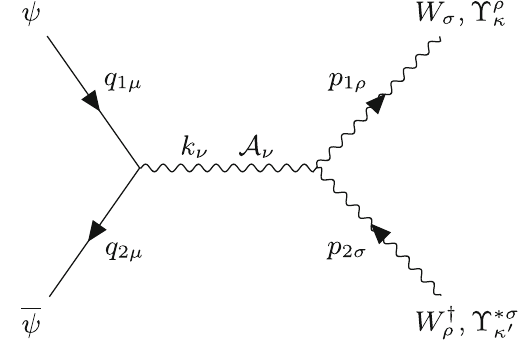
Fig. 17 Feynman-like diagram representing the DY process of the spin-1 monopole. The quarks annihilate to a photon through an electromagnetic process, which subsequently decays to a monopole- antimonopole pair. The variable definitions are given in the